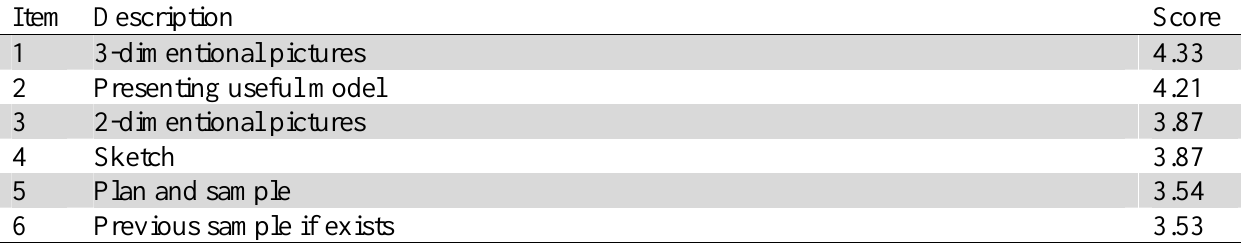
The summary of ranking various factors influencing on methods on predicting clients’